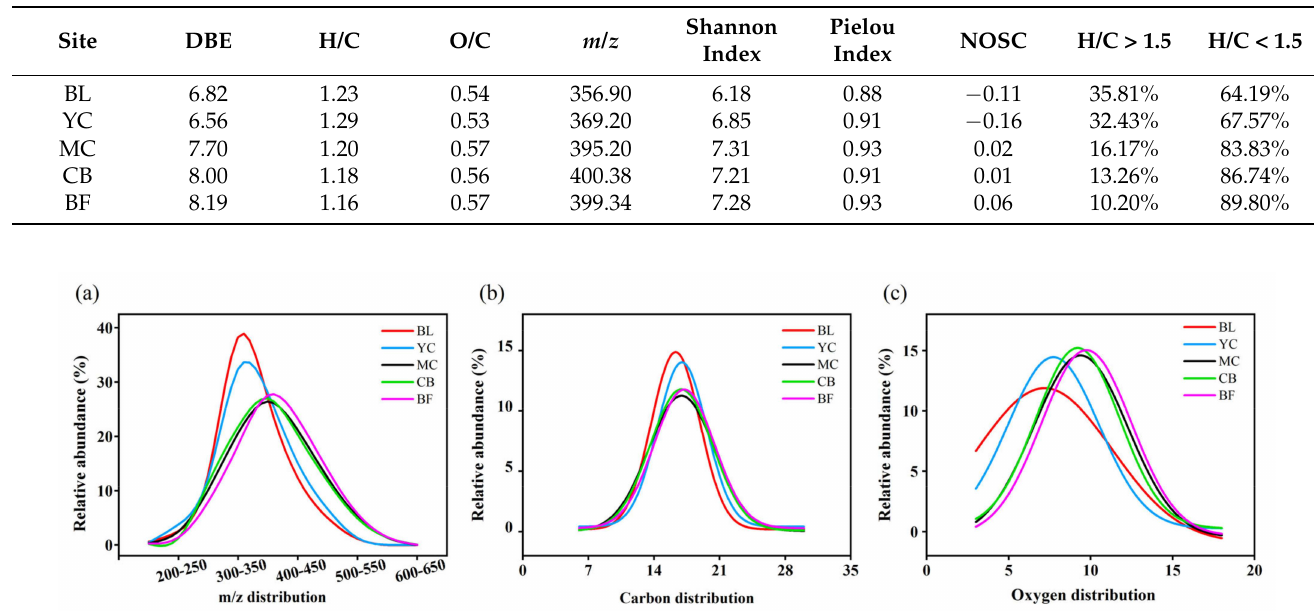
Table 1. Characteristics of soil dissolved organic matter (DOM) in five plots of different forest types, BL, YC, MC, CB, and BF, after vegetation restoration, such as the intensity-weighted average of the molecular composition of soil samples, double bond equivalent (DBE), hydrogen/carbon (H/C), oxygen/carbon (O/C), the Shannon index, Pielou’s evenness index, the NOSC (average nominal oxidation state of carbon), DOM molecules with H/C > 1.5, and DOM molecules with H/C < 1.5. BL: bare land; YC: newly restored young coniferous forest; MC: slightly more mature coniferous forest; CB: mixed coniferous and broadleaf forest; BF: broad-leaved forest.